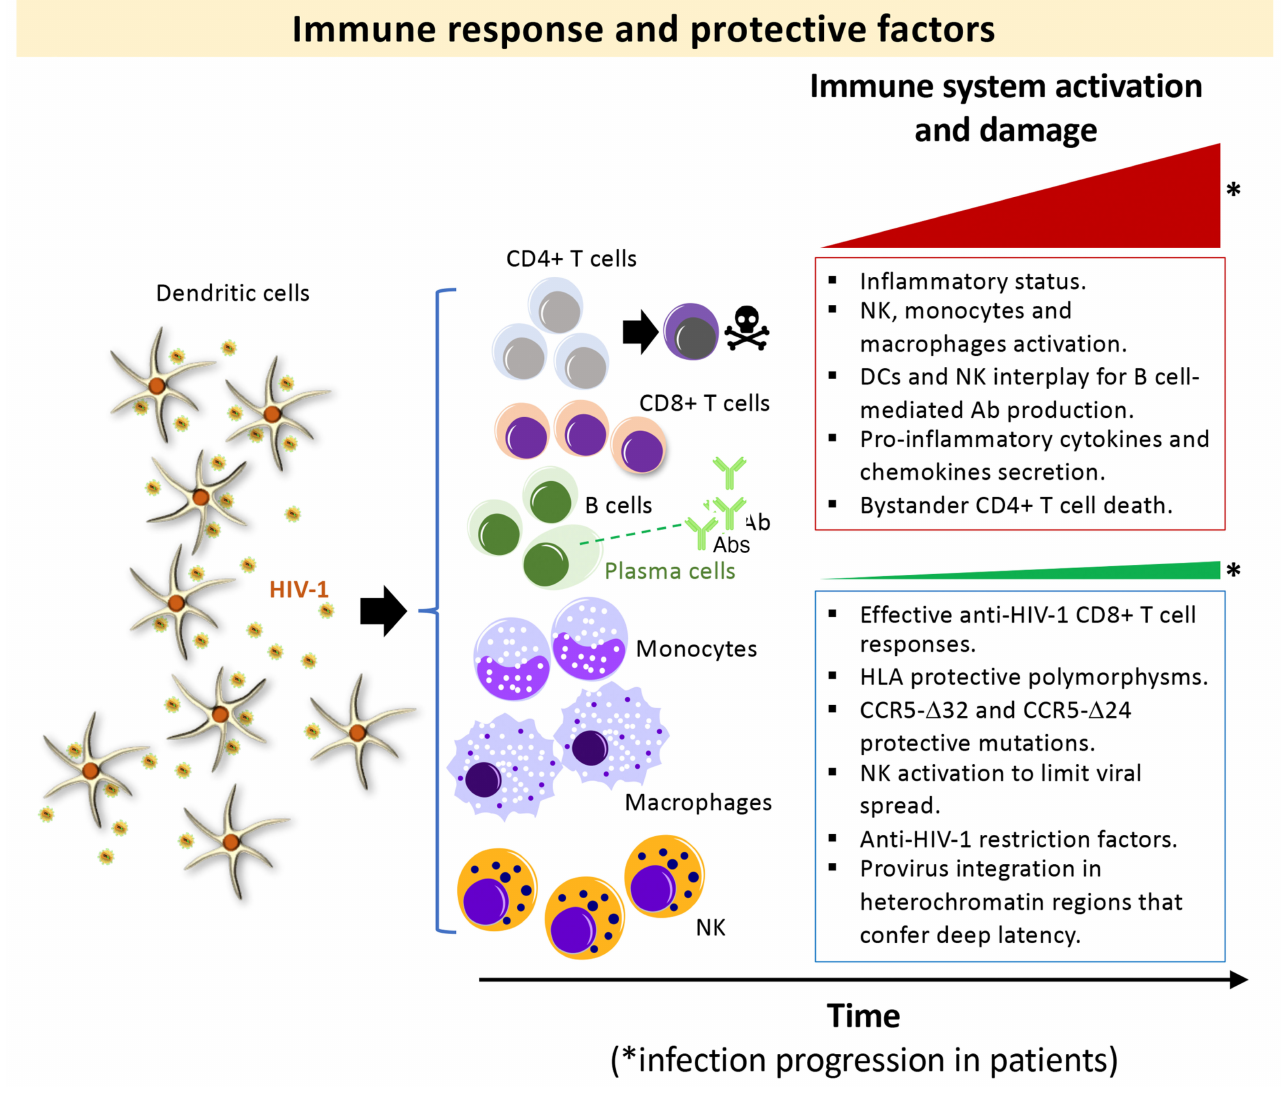
Figure 1. Scheme summarizing the events in primary HIV-1 infection associated with the im- mune control and damage, in HIV-1 progressor and non-progressor phenotypes: Main immune responses and damage associated with progressors HIV-1 infected individuals ( top box ) and non- progressors ( bottom box ) clinical phenotypes. Top box , in an acute phase of the HIV-1 infection, antigen-elicited rapid responses of innate immune cells lead to the activation of natural killer (NK) cell receptors together with monocytes/macrophages and the release of inflammatory cy- tokines/chemokines. This HIV-1 elicited-NK cells activation leads to secretion of IFN- γ and MIP-1 β to limit viral spread [108], modulate the adaptive response in an interplay with DCs [109], and shape the induction of antibodies through the elimination of follicular T cells (Tfh) [110]. Macrophages and microglia that survive after acute HIV-1 infection could become viral reservoirs [111]. High VL is associated with predominant destruction of bystander non-infected CD4+ T mediated by HIV-1 Env (reviewed in [2,112,113]), a process we have previously reported to be dependent on the HIV-1 gp41-Env subunit by promoting autophagy and apoptosis [114–119]. Bottom box , some host factors, such as viral antigen-elicited CD8+ T cell response and Th1-type cytokine production [66,105–107], NK cell receptors [67], HLA polymorphisms [61] and CCR5 protective mutations (i.e., homo and het- erozygous CCR5- ∆ 32 and heterozygous CCR5- ∆ 24 deletions/genotypes) [45,48–54,56] together with a limited pro-viral reservoir [68] and some restriction factors [69] have been related to a